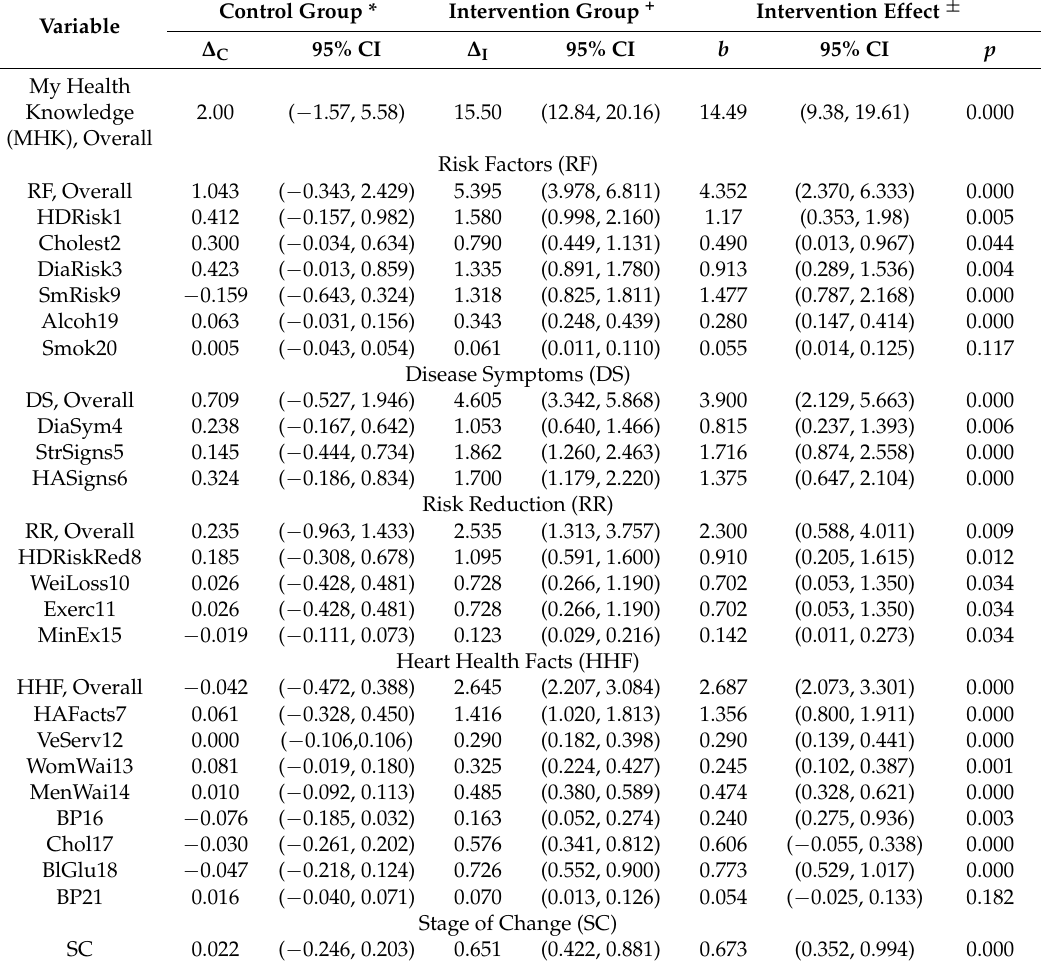
Table 2. A comparison of study outcomes for the intervention and control